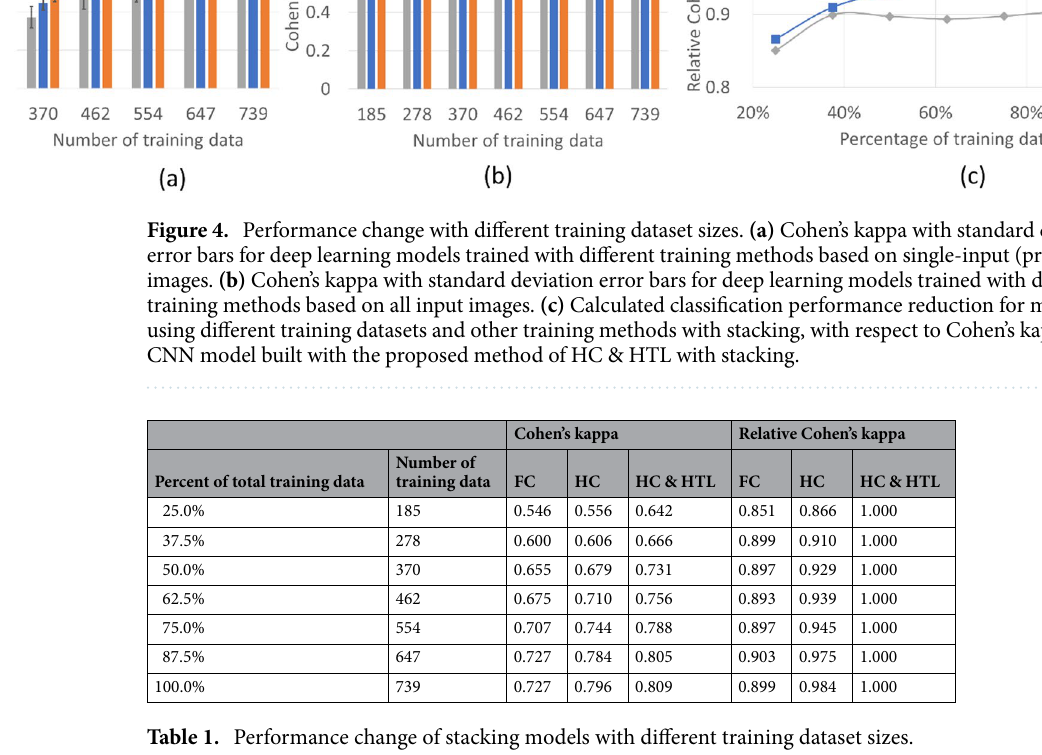
Table 1. Performance change of stacking models with different training dataset